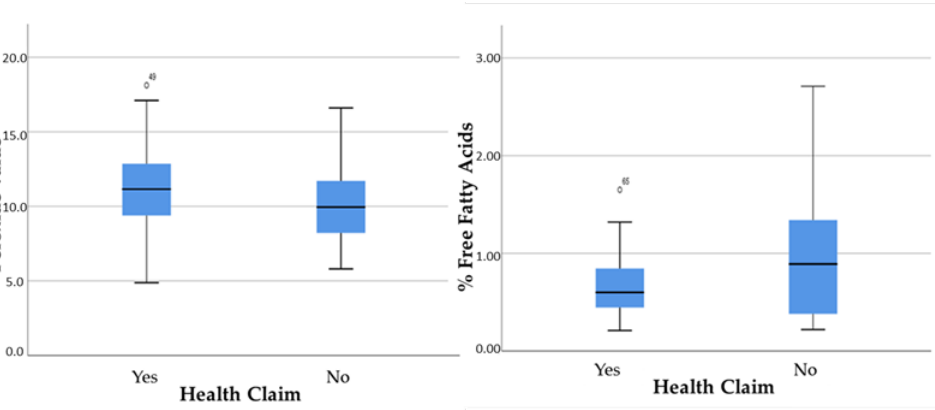
Figure 7. Comparison of the % free acidity ( right ) and the peroxide value ( left ) with the results for the health claim.